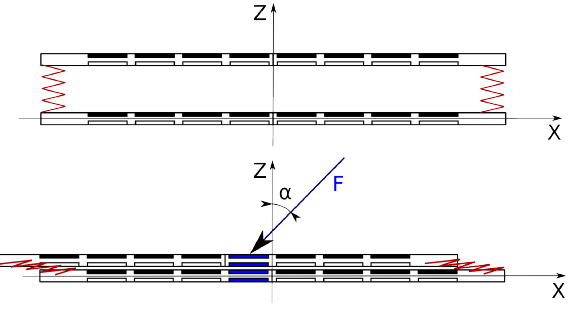
Figure 7. The idea of pressure vector